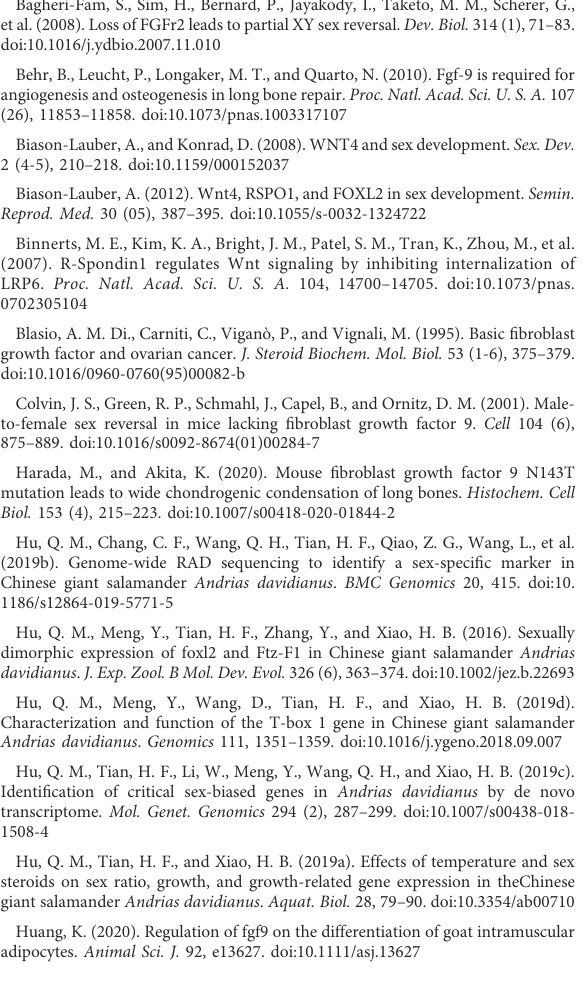
SUPPLEMENTARY FIGURE S1 Multiple alignment of the FGF9 amino acid sequence (A) and NJ phylogenetic tree (B) . SUPPLEMENTARY FIGURE S2 Multiple alignment of the RSPO1 amino acid sequence (A) and the NJ phylogenetic tree (B) . SUPPLEMENTARY FIGURE S3 Result of in situ hybridization with fgf9 (A) and rspo1 (B) sense 628 probe; no positive signal was